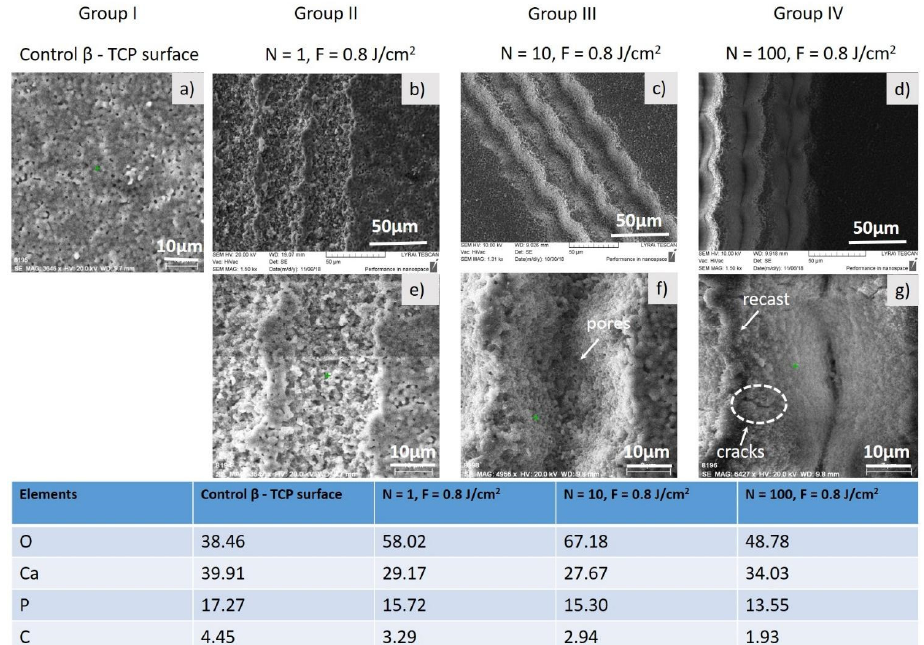
Figure 2. Scanning electron microscopy (SEM) images ( a – g ) and table of energy—dispersive X-ray spectroscopy (EDX) results, showing element concentration [wt.%] of β -tricalcium phosphate ( β -TCP) pellets, as follows (from left to right): untreated surface (control) and treated with N = 1, 10, and 100 pulses; F = 0.8 J/ cm 2 ; λ = 800 nm; τ = 130 fs.